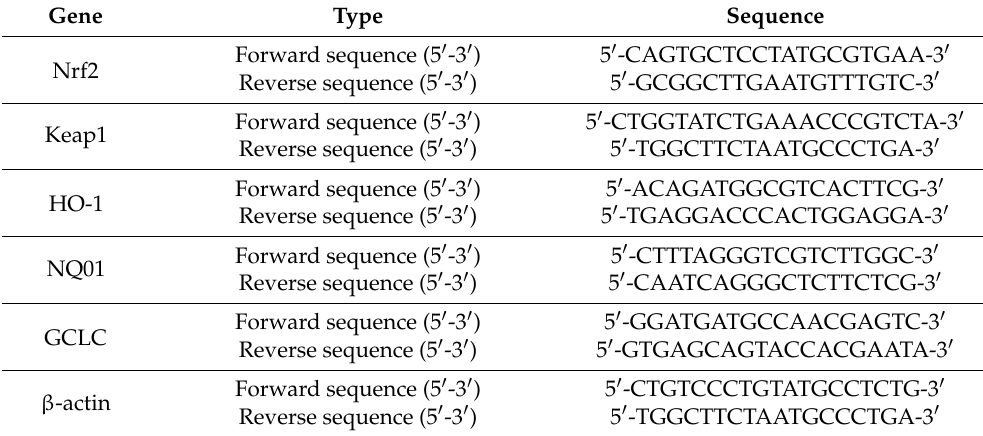
Table 1. Primer used for qPCR in this experiment.